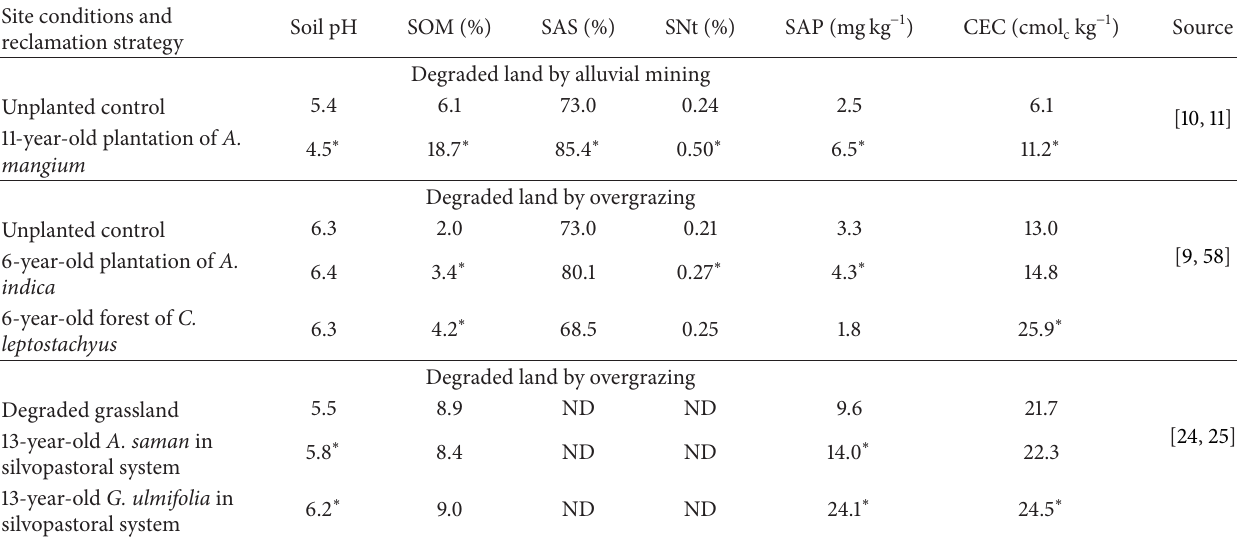
Table 5: Changes in some soil properties of degraded soils in Colombia by the establishment of forestry species. Site conditions